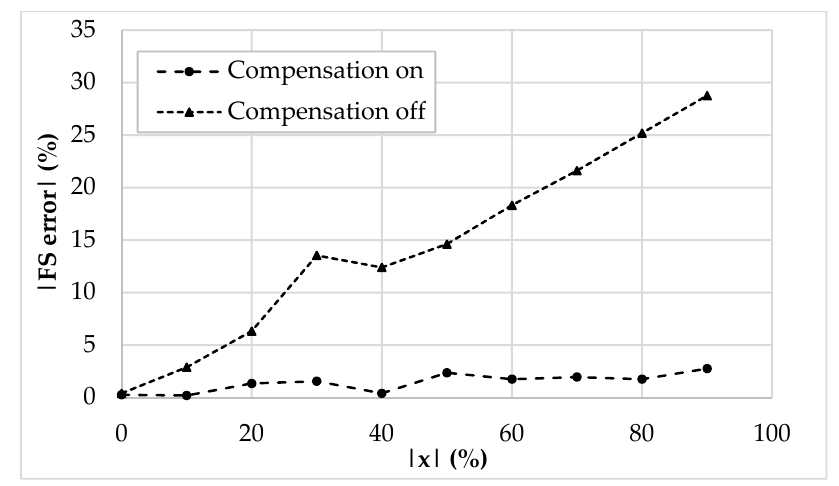
Figure 13. Full-scale error (%) of the compensated and uncompensated prototyped interface.